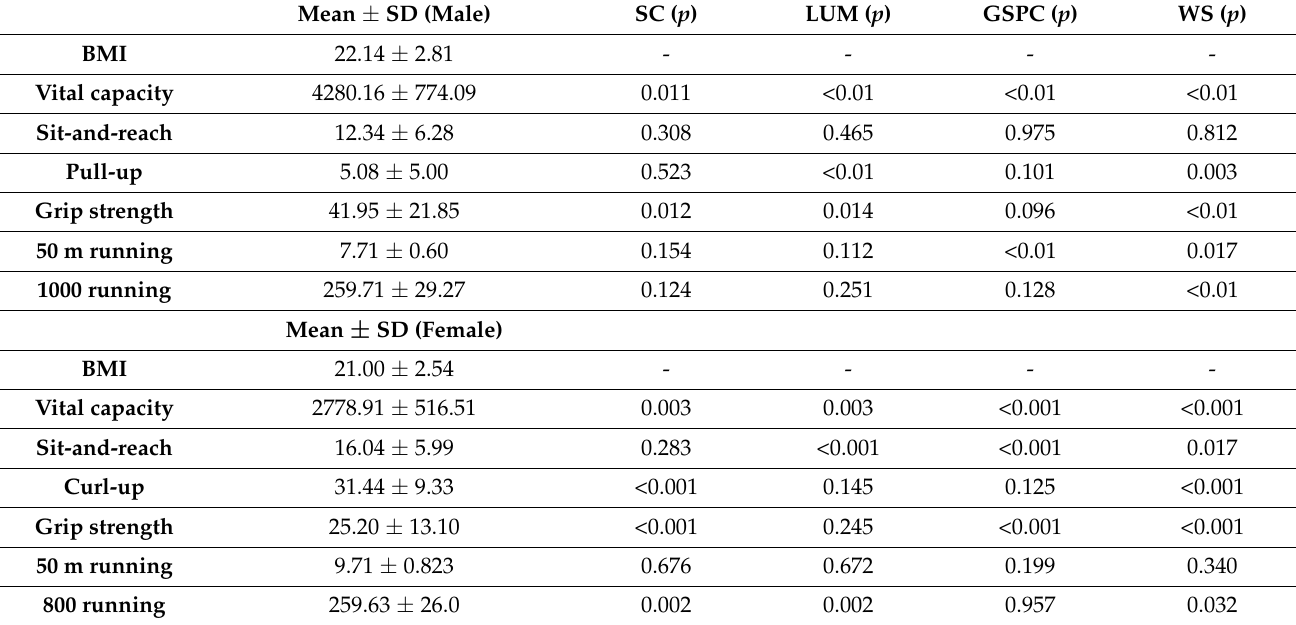
Table 6. The results of Spearman correlation: associations of students’ physical health with the built environment in